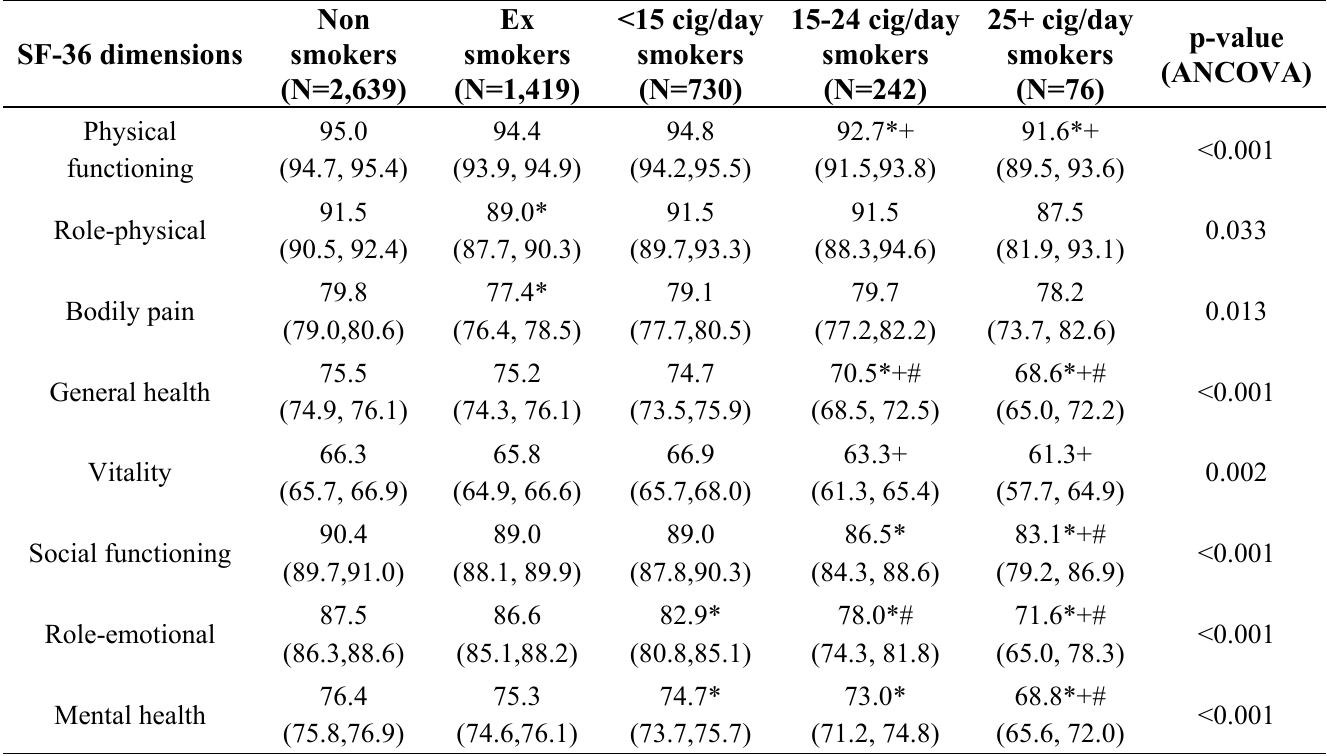
Table 2. Age and sex adjusted mean scores (95% confidence interval) by smoking status on the SF-36 health status questionnaire. SUN study participants